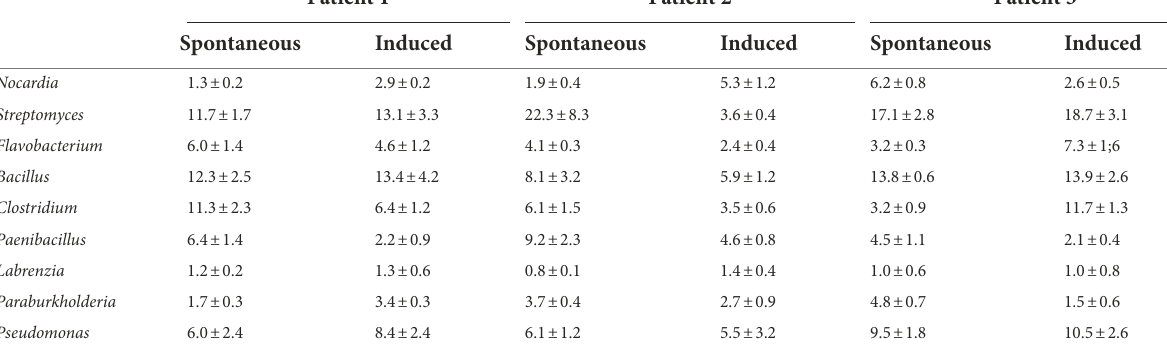
TABLE 4 Microbial genera systematically identified in the three patients.